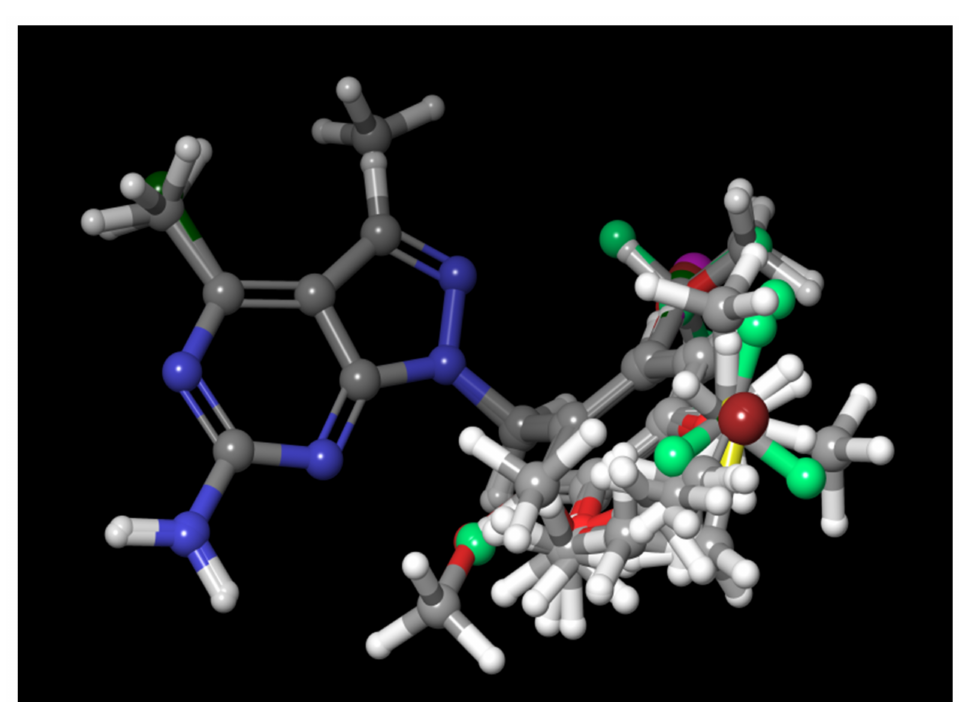
Figure 2. Alignment of common pharmacophoric